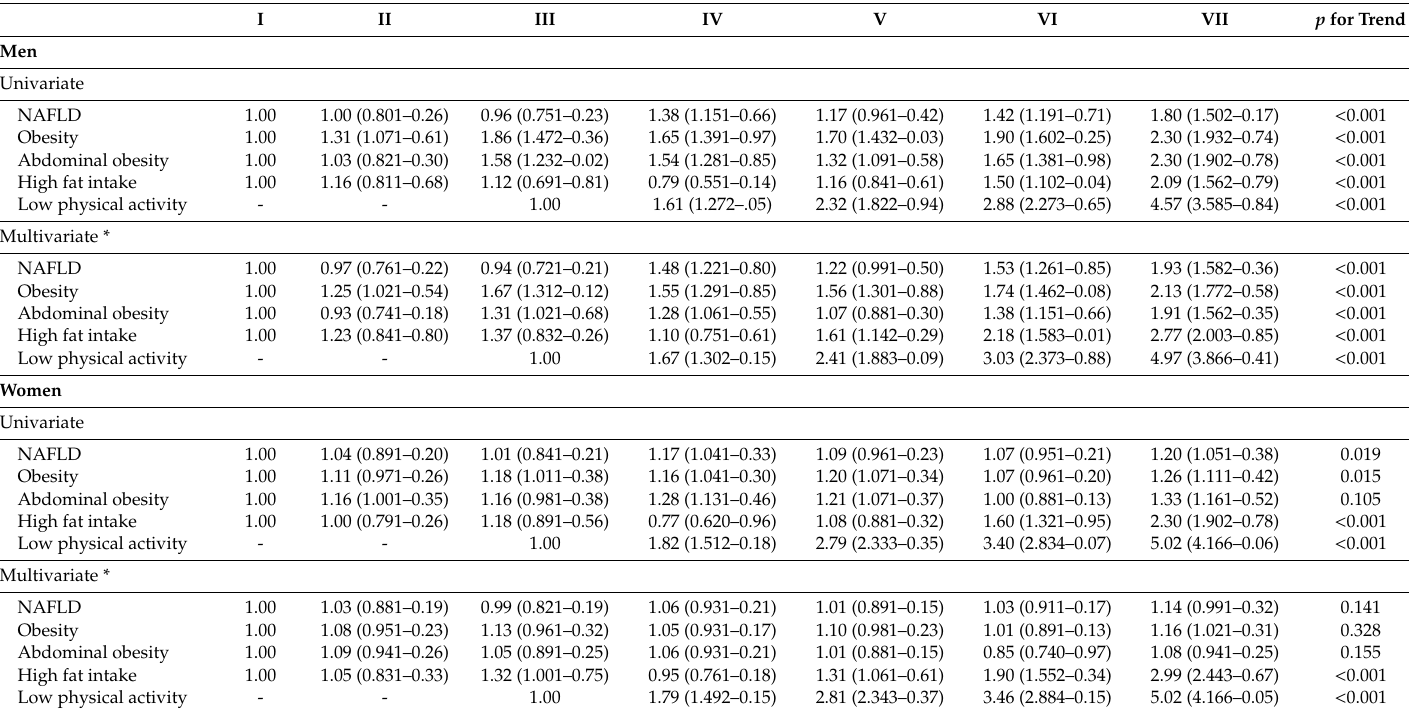
Table 3. Odds ratios (ORs) and 95% confidence intervals (CIs) for NAFLD and associated factors in the study participants, KNHANES waves